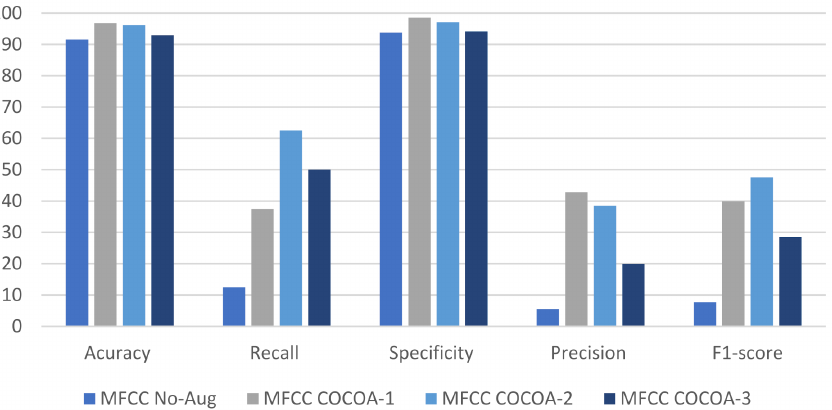
Figure 8. Comparison of metrics for classification of Positive Asymptotic vs. Healthy (Mel- spectrogram images).